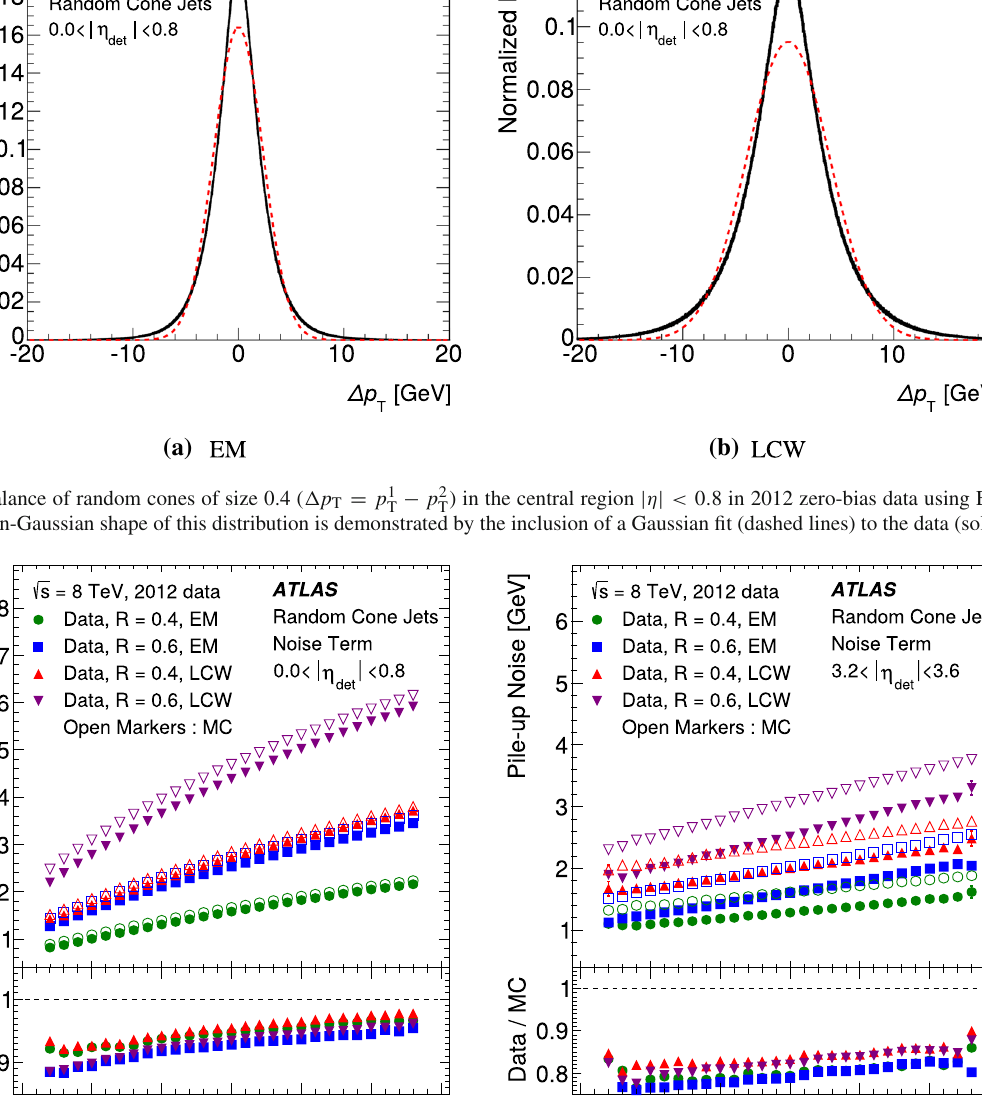
both the EM and LCW scales probing two calorimeter | η | regions, one central ( | η | < 0 . 8) and one forward (3 . 2 < | η | < 3 . 6). A scale factor of 1.09 has been applied to μ in the MC simulations to correct for extra activity observed in the minimum-bias